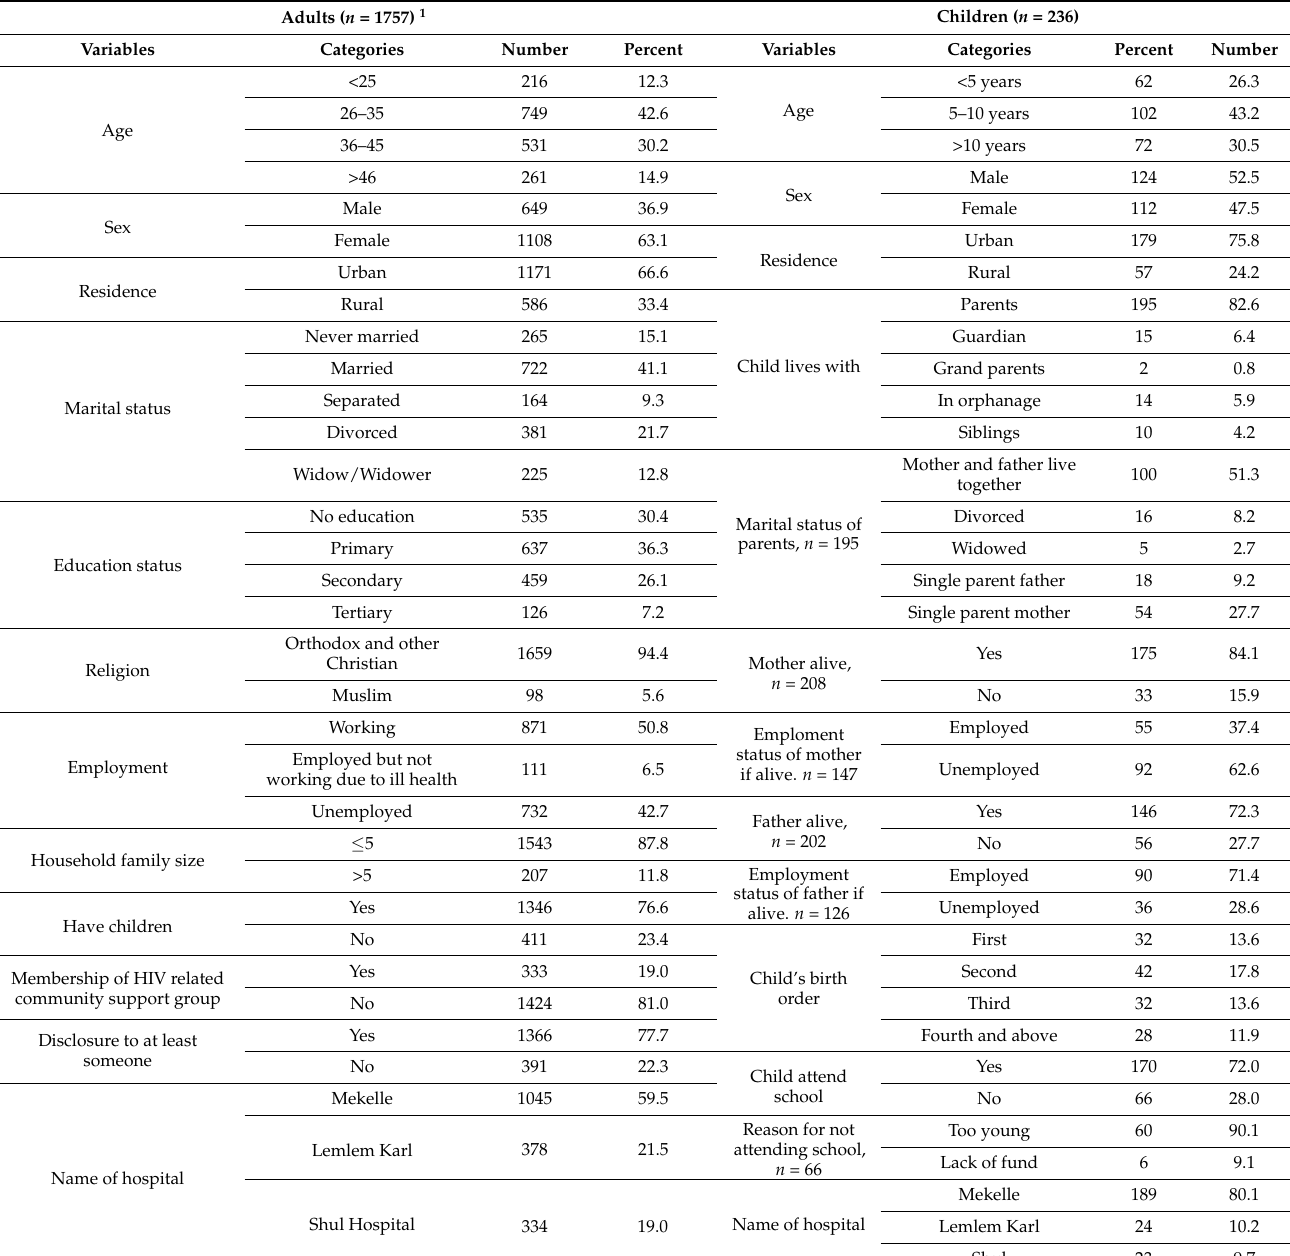
Table 1. Demographic and socioeconomic data of adults and children enrolled in the nutritional